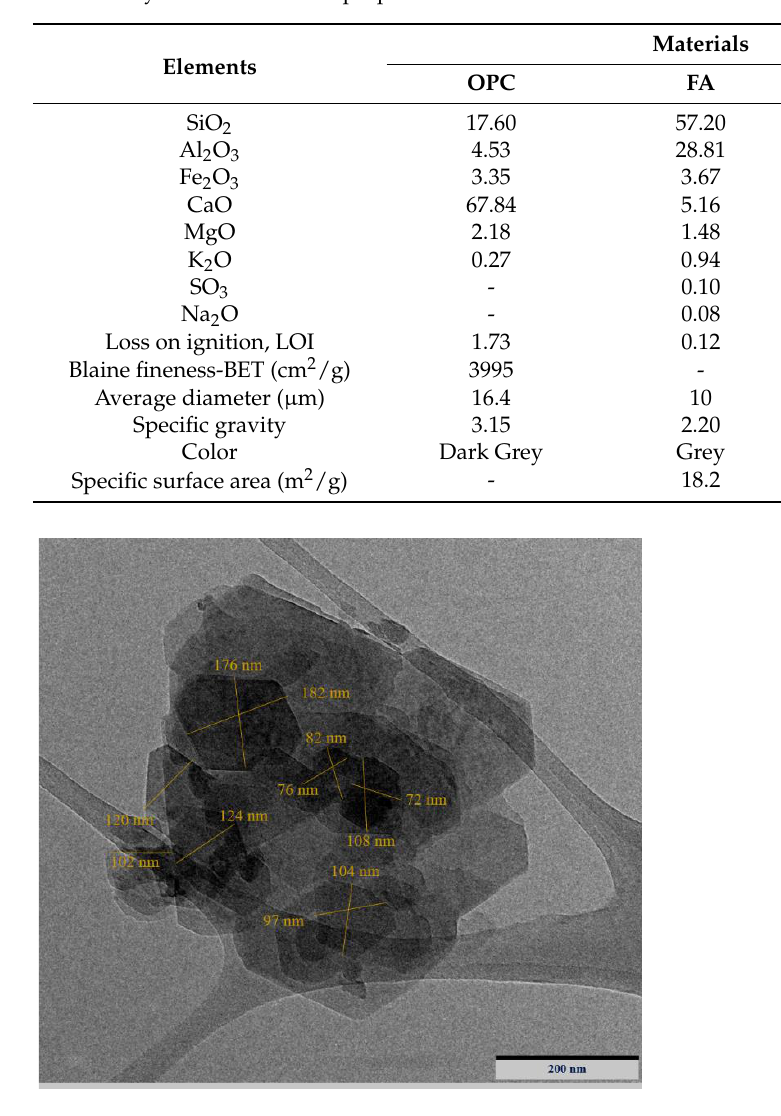
Table 1. Physical and chemical properties of raw materials.